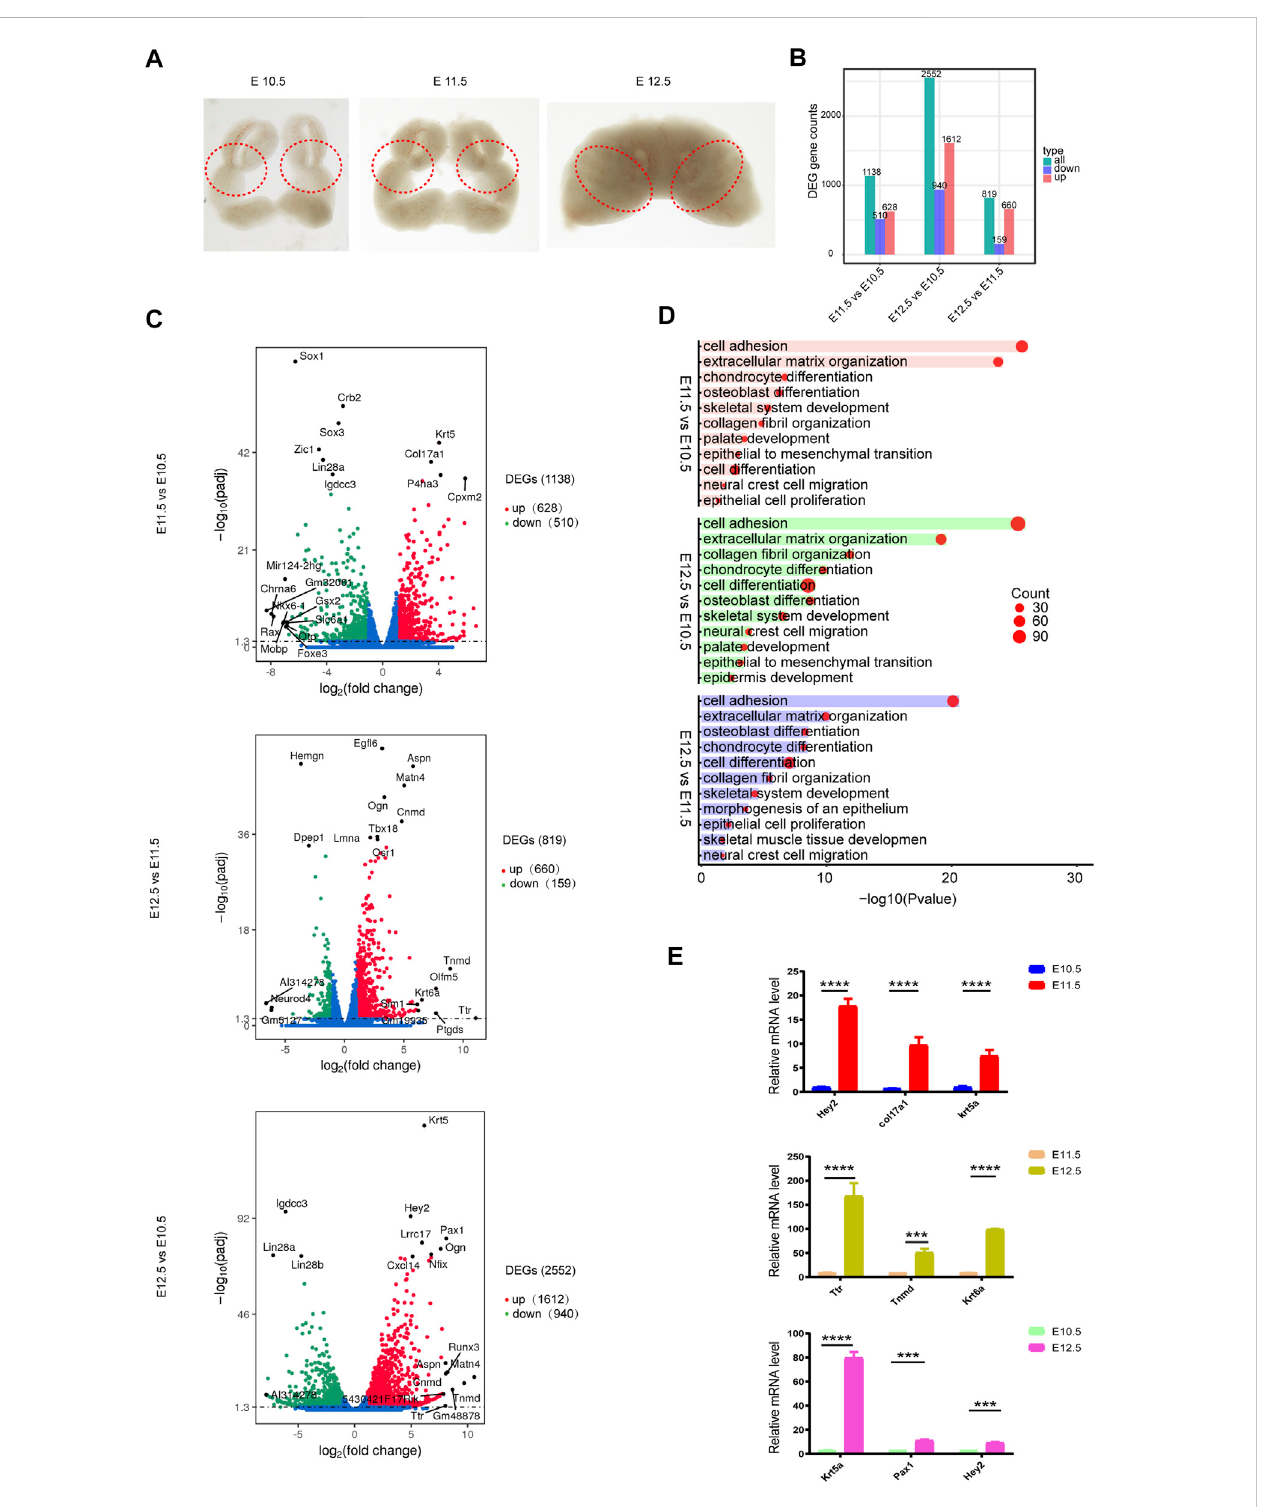
FIGURE 1 Transcriptomicchangesduringupperlipandprimarypalatedevelopment. (A) Lambdoidaljunctiontissuesofmiceatembryonicdays10.5,11.5,and12.5. (B) Histogram showing upregulated and downregulated DEGs for comparison groups E11.5 vs. E10.5, E12.5 vs. E10.5, and E12.5 vs. E11.5, respectively. (C) Volcanoplots showingupregulatedanddownregulatedDEGsincomparisongroupE11.5vs.E10.5(upper),E12.5vs.E11.5(middle),andE12.5vs.E10.5(lower), respectively. (D) Gene ontology analysis of upregulated DEGs in comparison group E11.5 vs. E10.5 (upper), E12.5 vs. E10.5 (middle), and E12.5 vs. E11.5 (lower), respectively. Circle size: gene number; bar length: range of p values. (E) Quantitative PCR validation of representative genes. * p <